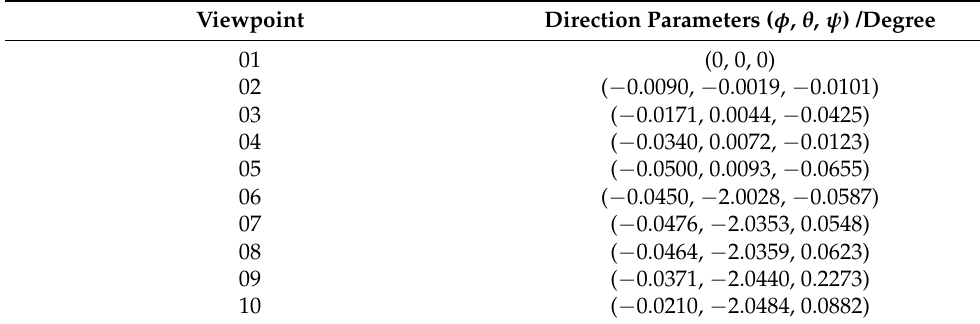
Table 2. The aiming direction parameters of the camera system from the 1-by-10 views.